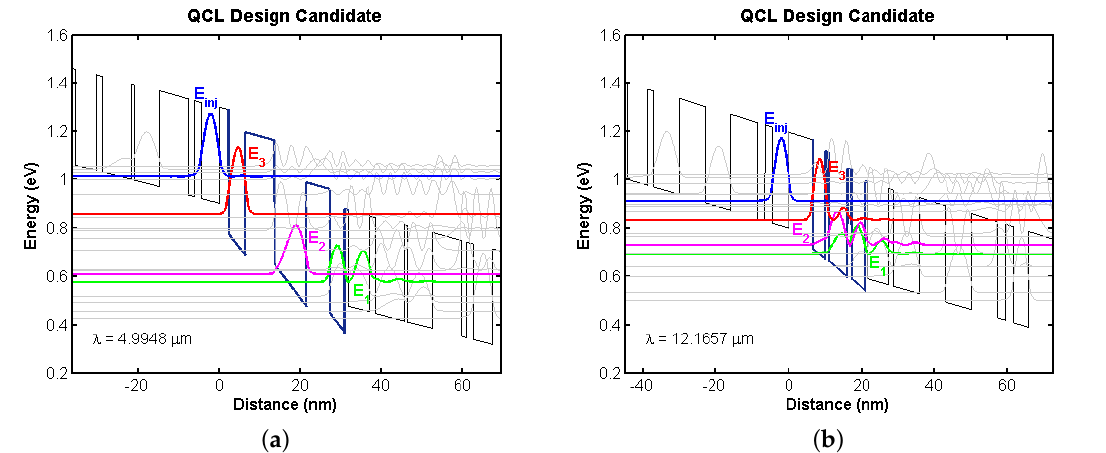
Figure 12. Al x Ga 1 − x As/In y Ga 1 − y As QC laser candidates simulated on GaAs (111). ( a ) candidate with top aggregate fitness rank and ( b ) candidate showing diversity of